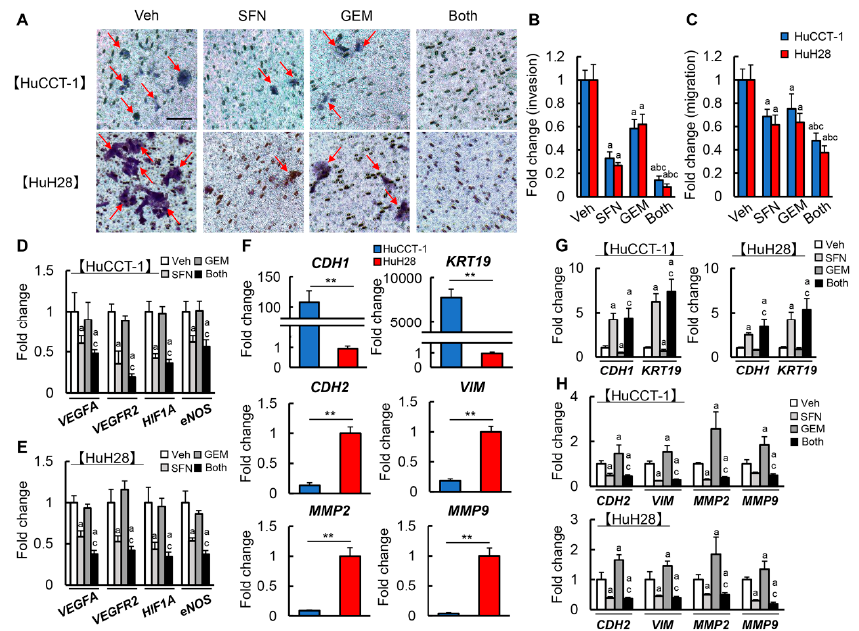
Figure 4. Cell invasion, pro-angiogenic property and EMT by treatment with SFN and GEM in iCCA cells. ( A ) Representative images of invasive HuCCT-1 and HuH28 cells treated with SFM and/or GEM. Scale bar; 50 μ m. Red arrow; invasive cells. ( B ) Quantification of both cell lines invasion. ( C ) Quantification of both cell lines migration. ( D , E ) Relative mRNA expression of pro-angiogenic markers (VEGFA, VEGFR2, HIF1A, and NOS3) in HuCCT-1 and HuH28 treated with SFN and/or GEM. ( F ) Comparison between HuCCT-1 and HuH28 in the relative mRNA expression of the epi- thelial markers (CDH1 and KRT19) and mesenchymal markers (CDH2, VIM, MMP2 and MMP9) related to EMT. ( G , H ) Relative mRNA expression of epithelial markers ( G ) and mesenchymal mark- ers ( H ) in HuCCT-1 and HuH28 treated with SFN and/or GEM. GAPDH was used as an internal control for qRT-PCR. The values are shown as fold changes relative to the vehicle-treated group (Veh) ( B – E , G , H ) or the values of the HuCCT-1 group ( F ). Data are mean ± SD ( n = 3 independent experiments with n = 6 for B and n = 8 for B–G samples per condition); a p < 0.01, b p < 0.01, c p < 0.01 compared with the group treated with Veh, SFN or GEM, respectively ( B – E , G , H ). ** p < 0.01, indi- cating a significant difference between groups ( F ).